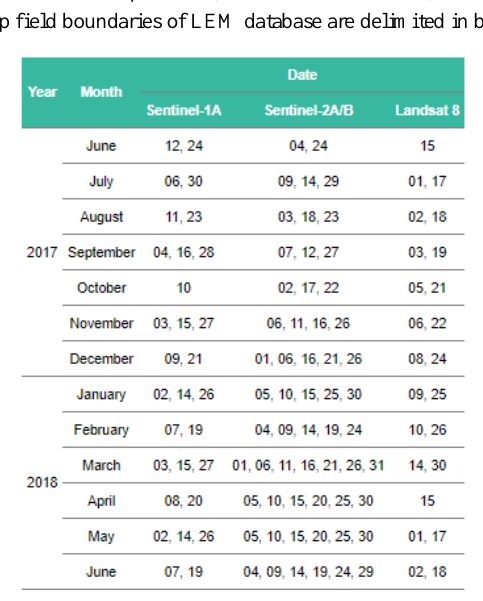
Table 1. Set of multi-temporal remote sensing images of LEM database: Landsat-8/OLI, Sentinel-2/MSI and Sentinel-1 image acquisitions dates over LEM municipality between June 2017 and June 2018 (2017-2018 Brazilian crop